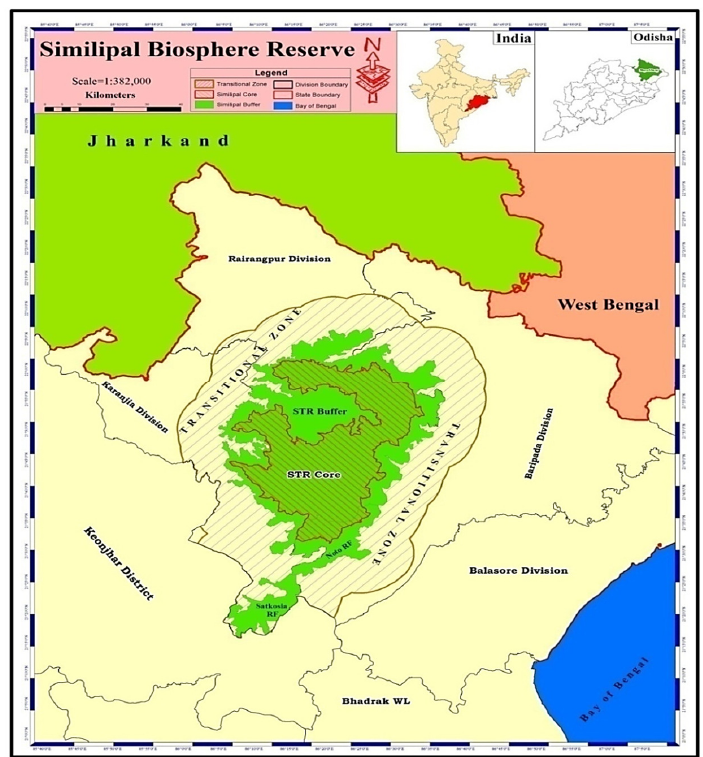
Figure 1. Map of Similipal Biosphere Reserve (SBR), Odisha,